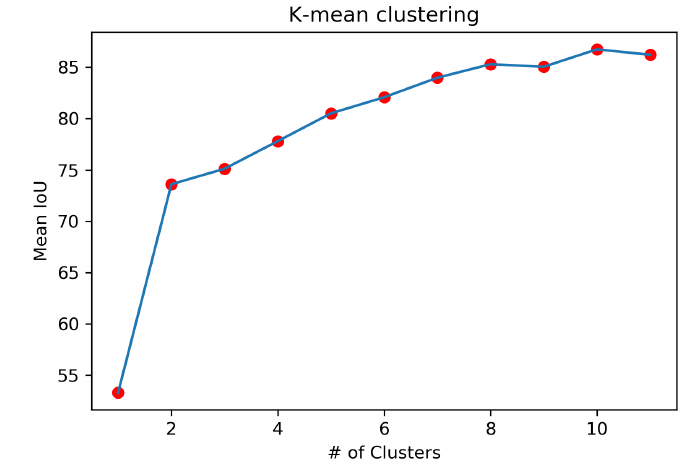
Figure 8. Clustering box dimensions on Chinese character datasets. Table 2. Performance comparison based on the number of layers when not using a pre-trained network.